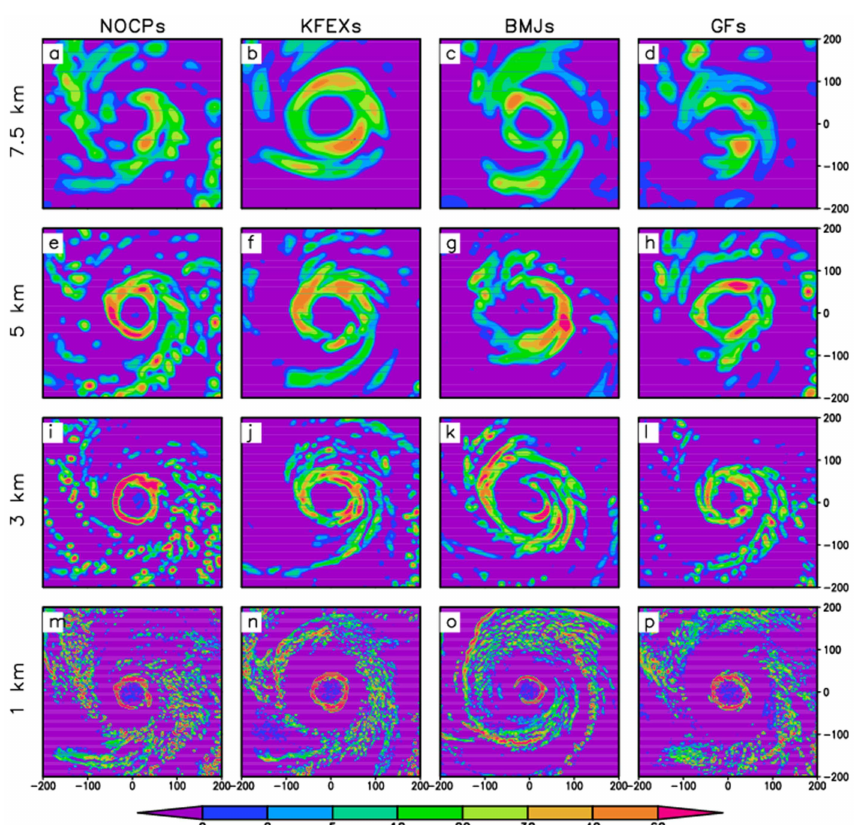
Figure 4. Horizontal cross sections of time-averaged diabatic heating ( ◦ C h − 1 ) in the TC mature stage. The time-average interval is one hour. The model resolution is 7.5 km ( a – d ), 5 km ( e – h ), 3 km ( i – l ) and 1 km ( m – p )